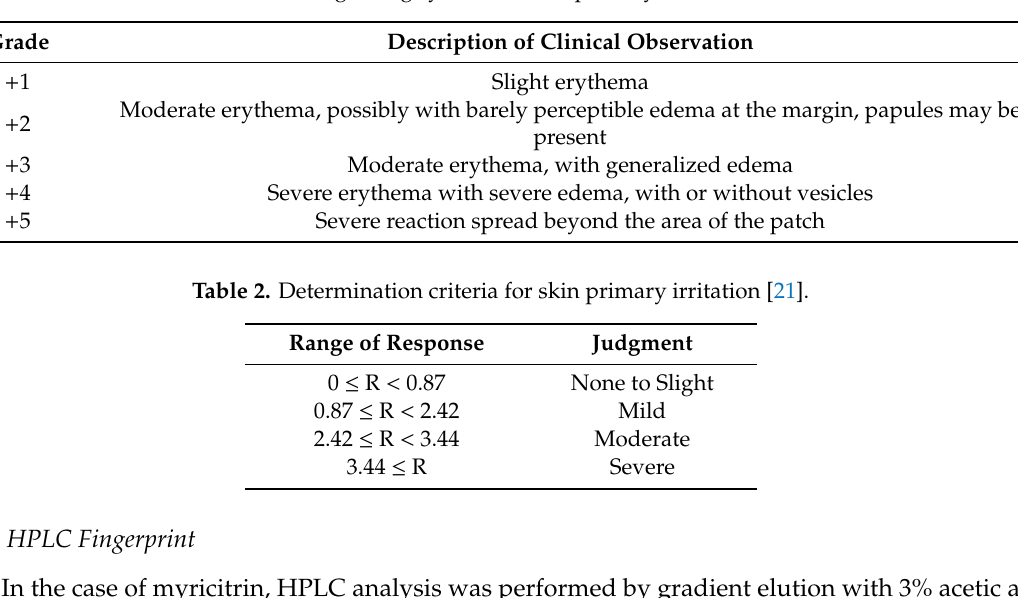
Table 1. The grading system for skin primary irritation test.